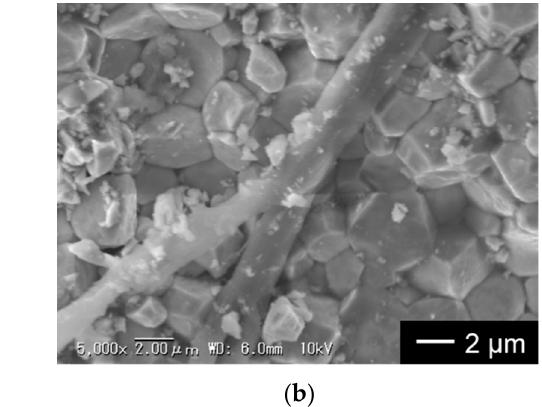
Figure 7. SEM images for cross sections of LLZT pellets removed from Li/LLZT/Li cells after a short circuit occurred: ( a ) R Li-LLZT (27 °C) = 100 Ω cm 2 and ( b ) R Li-LLZT (27 °C) = 25 Ω cm 2 .